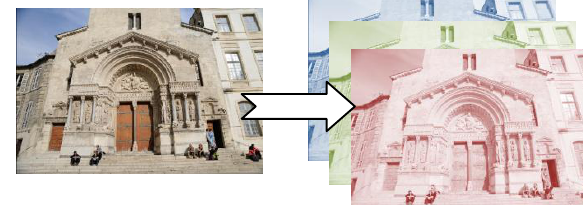
Figure 4: Structure of a TIFF file with the three color’s layers: Red, Green, Blue Figure 6: Steps of transfer: (a) definition of the annotation on the middle image, (b) research of X, Y and Z coordinate of the area, (c) projection on the other